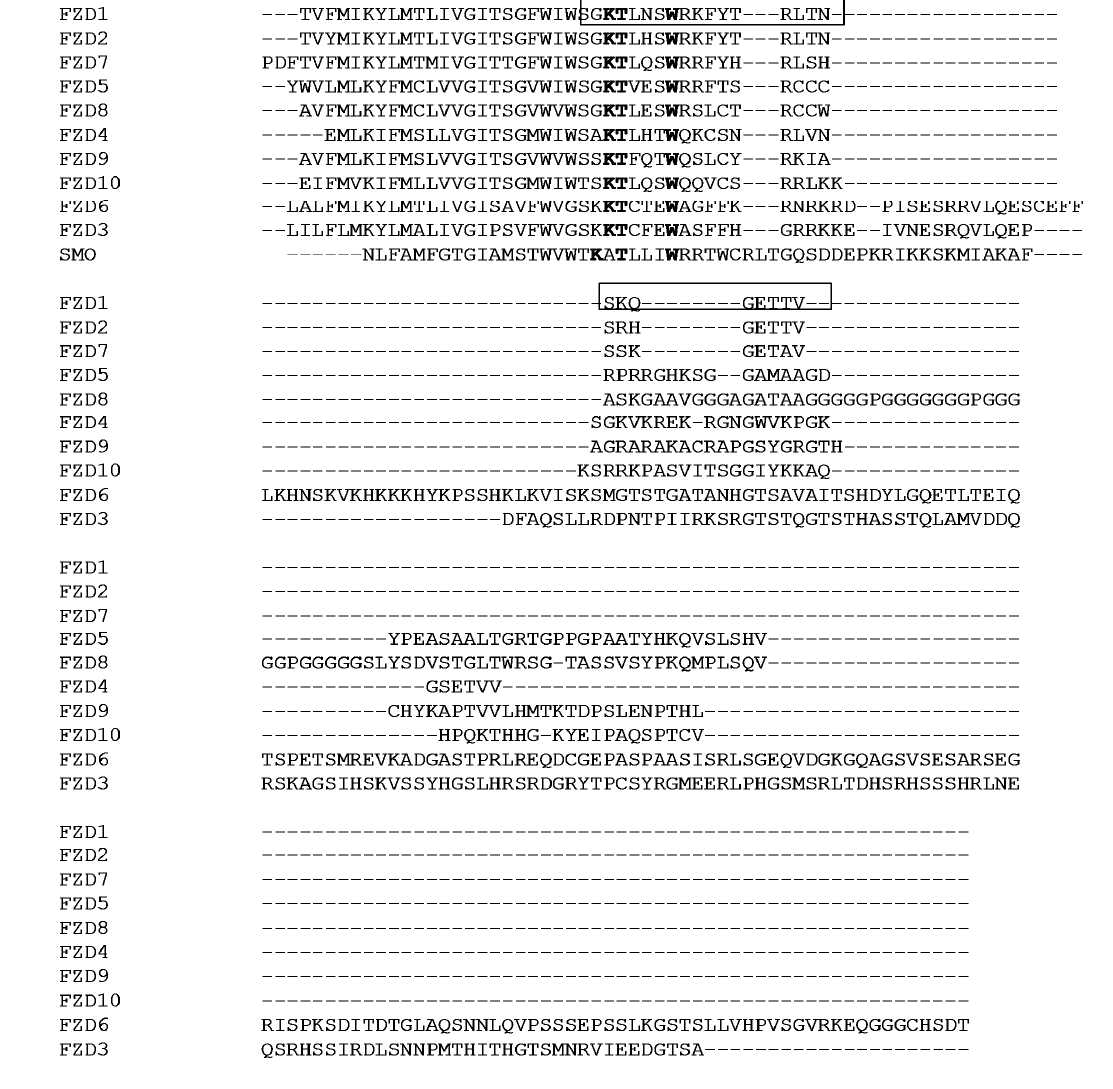
Figure 1. Sequence alignment of the C-terminal domains of the FZDs and SMO. The C-terminal domains from ten FZDs (FZD ) and SMO were aligned using ClustalW 1–10 (http://www.ebi.ac.uk/Tools/msa/clustalw2/). The conserved KTXXXW motif is highlighted in bold. The sequence used in the study is shown with a box. The protein sequences were obtained from protein knowledgebase (http://www.uniprot.org) with the , Q9UP38; FZD , Q14332; FZD , Q9NPG1; FZD , following accession numbers: FZD 1 2 3 4 Q9ULV1; FZD , Q13467; FZD , O60353; FZD , O75084; FZD , Q9H461; FZD , 5 6 7 8 9 O00144; FZD , Q9ULW2; SMO, Q99835. For clarity, only a partial sequence from the 10 C-terminus of SMO is